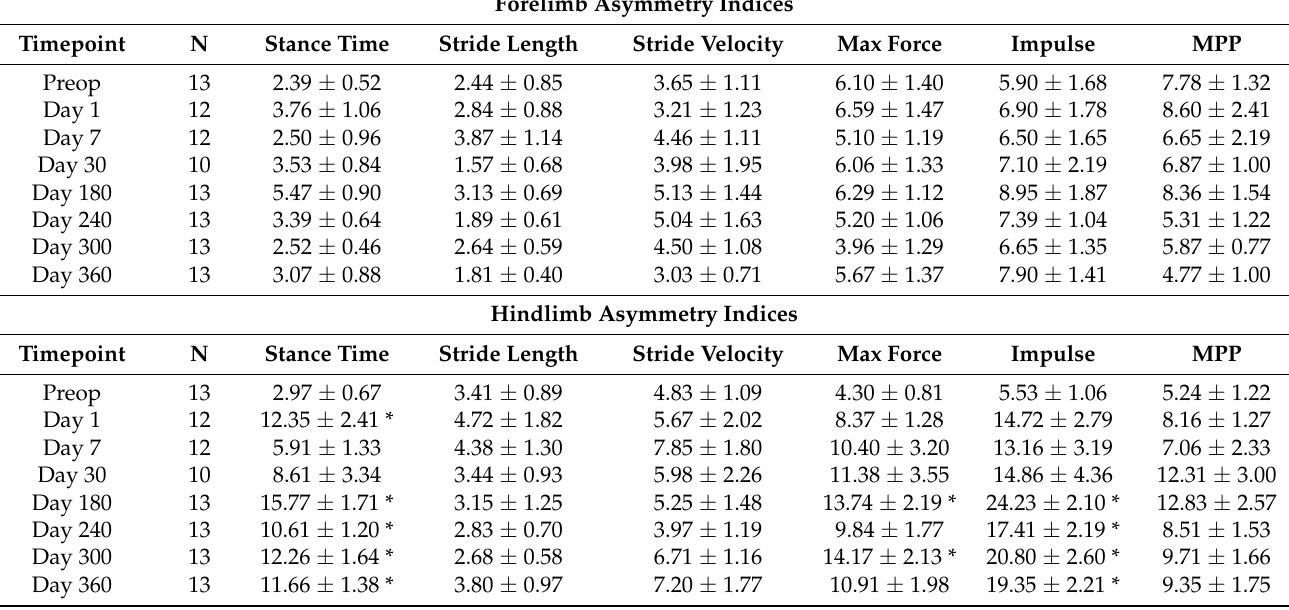
Table 3. Forelimb and hindlimb kinetics following right hindlimb tibial segmental defect and locking plate stabilization and right hindlimb cast immobilization. All values are presented as mean ± standard deviation. Forelimb Asymmetry